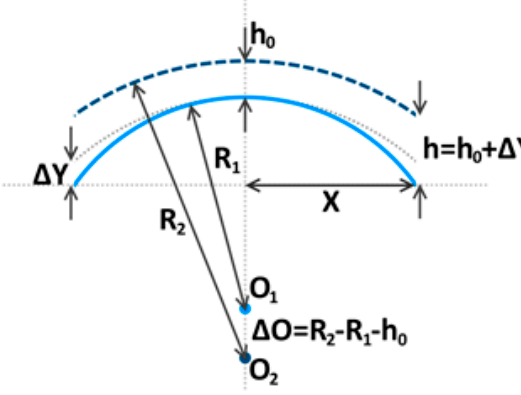
Figure 7. Diagram to calculate the cavity spacing of the lens when using Equation (4).